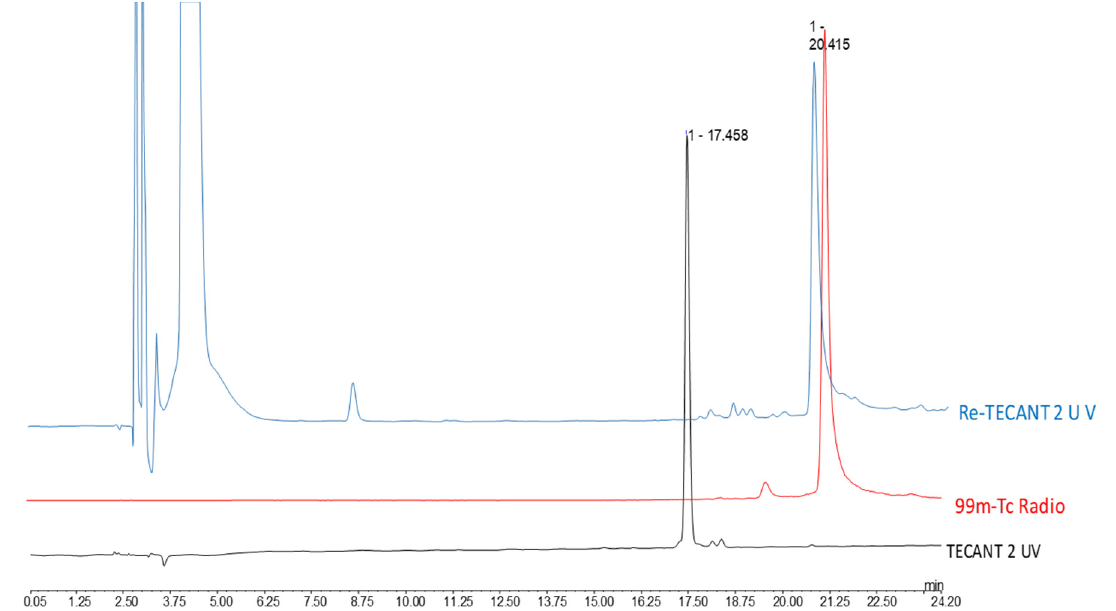
Figure A2. HPLC chromatogram of [ nat Re]Re-, [ 99m Tc]Tc- and unlabelled TECANT-1 (confirmative mass spectrometry data available on request).